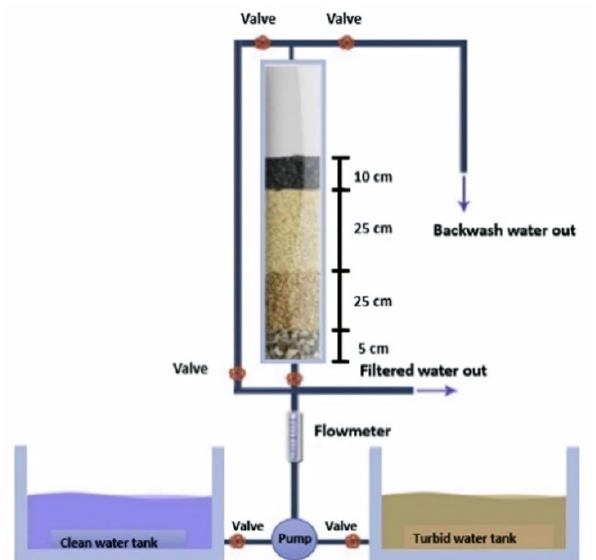
Figure 4. Multimedia sand filter unit for the pre-treatment of construction wastewater [62].